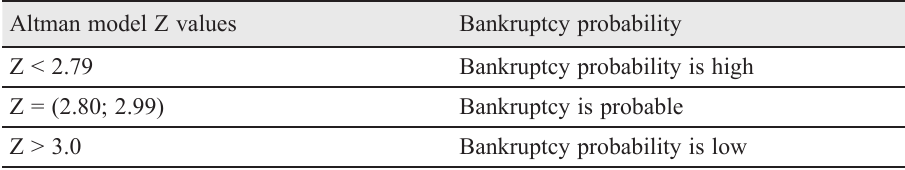
Fig. 4. AB “Ekranas” bankruptcy probability Fig. 5. UAB “Dainava” bankruptcy probability during 2001–2005, applying Altman model during 2006–2010, applying Altman model (the research carried out by the authors) (the research carried out by the authors) Table 3. Altman model